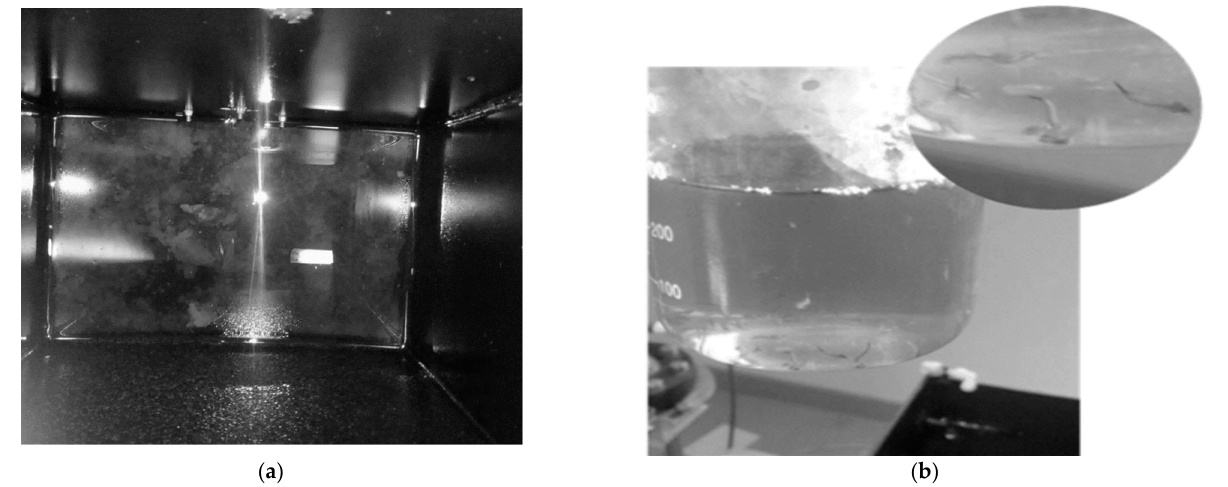
Figure 26. ( a ) Biofilm at the bottom of the membrane; ( b ) Membrane sample during treatment.